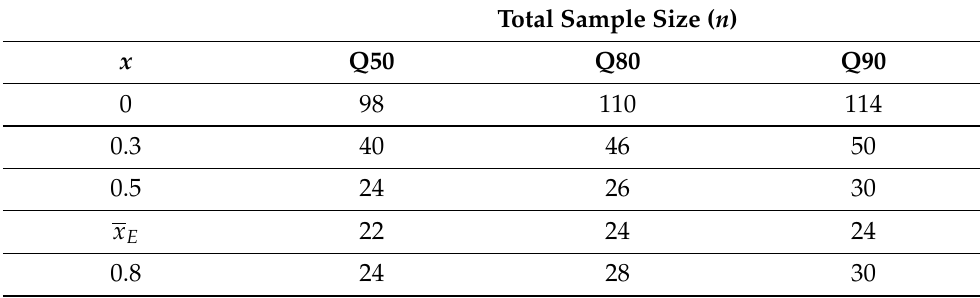
Figure 4. Distributions of the sample size to achieve 80% power of ANCOVA t -test of H 0 : ∆ x = 0 (using 2-sided α = 5%) for x = 0,0.3,0.5,0.8, and x = x E . Responses were simulated from model (1) with µ E = − 1, µ C = 0, γ = − 0.5, and σ = 1. Engagement values were simulated from a normal distribution with mean = 0.6 and SD = 0.3. Table 2. Summary statistics for the total sample size distributions (cf. Figure